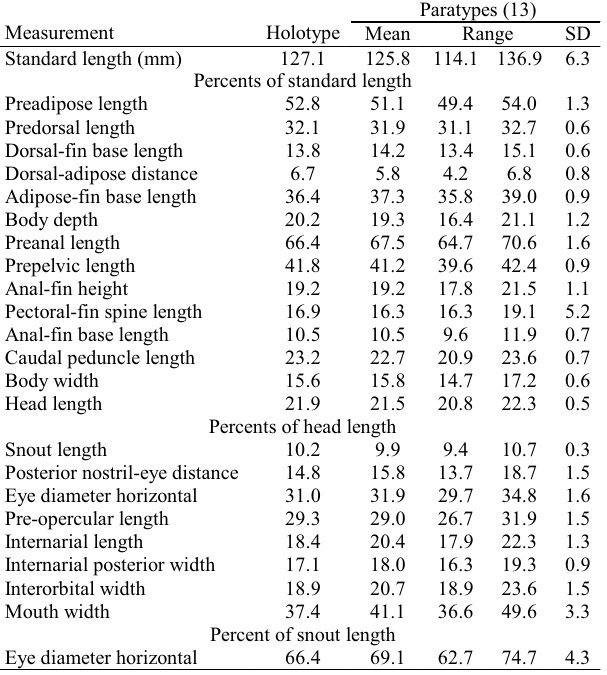
Table 1 . Morphometric data of Propimelodus araguayae . SD = standard deviations.